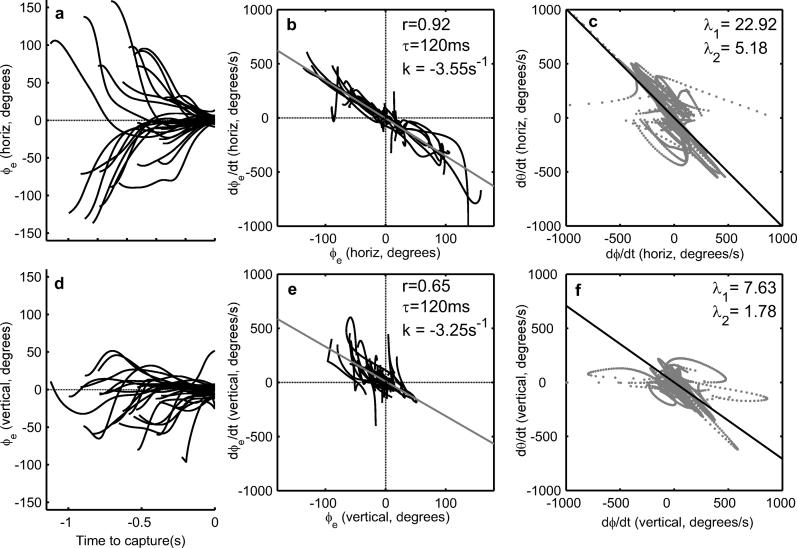
Bats Maneuver to Follow the Optimum Bearing by Keeping
dα/dt Low

φ
e is the deviation of the target bearing from the instantaneous optimum. Data is shown from captures of both free-flying (15 trials) and tethered insects (15 trials) by eight bats.
(A) Horizontal component of
φ
e. Time of insect capture is
t = 0. The bat reduces
φ
e during pursuit. For clarity each trial is shown from the instant the bat begins to maneuver to reduce
φ
e.
(B) The pursuit behavior is captured by a delay-differential equation (
Equation 5). The gain in the model is given by
k = −3.55 s
−1, and the delay is given by
τ = 120 ms. The linear fit has a correlation coefficient r = 0.92.
(C) The scatter plot of
dθ/dt against
dφ/dt has its principal component (
λ
1) (black line) along
y = −
x, indicating that
dφ/dt = −dθ/dt.
(D) Vertical component of
φ
e for the same trials and same part of pursuit as in (A).
(E) The bat follows a similar law in reducing
φ
e in the vertical plane.
k = −3.2 s
−1, τ = 120 ms, r = 0.65.
(F) The black line shows the principal component (λ
1) of
dθ/dt against
dφ/dt for vertical components of motion.